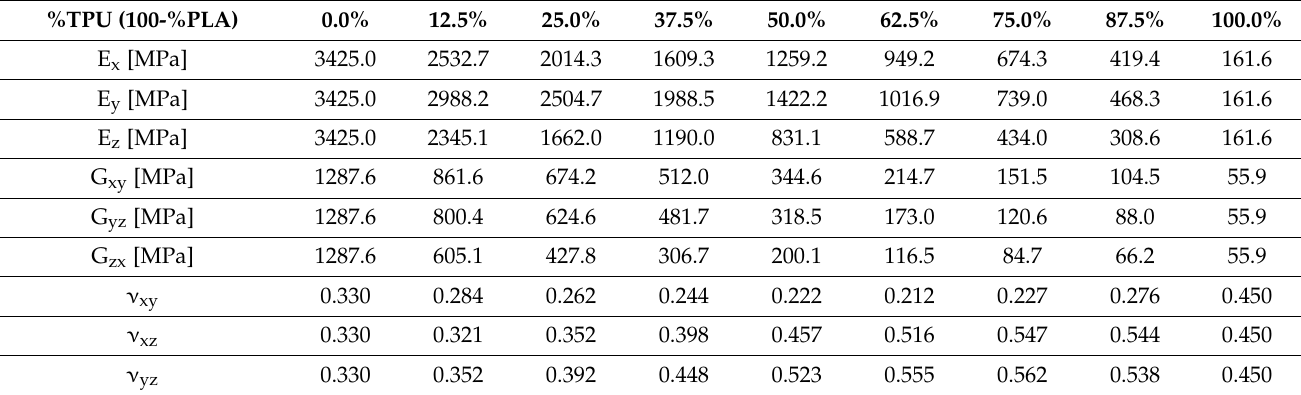
Table 5. Coefficients of the stiffness matrix, depending on the material fraction, obtained by homoge- nization of the PLA-TPU RVE.